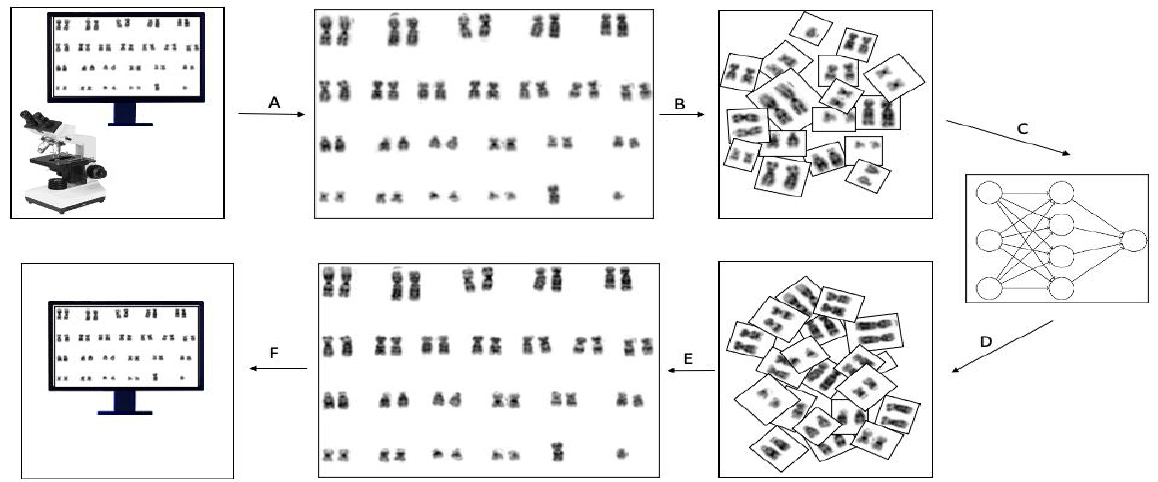
Figure 1. Pipeline of our method. ( A ) Karyogram taken from cytogenetics state-of-the-art system. ( B ) Cutting each pair of chromosomes. ( C ) Feeding each pair into the model. ( D ) The output of the pairs is gathered. ( E ) Reformed karyogram from the enhanced pair. ( F ) The karyogram is ready for analysis.